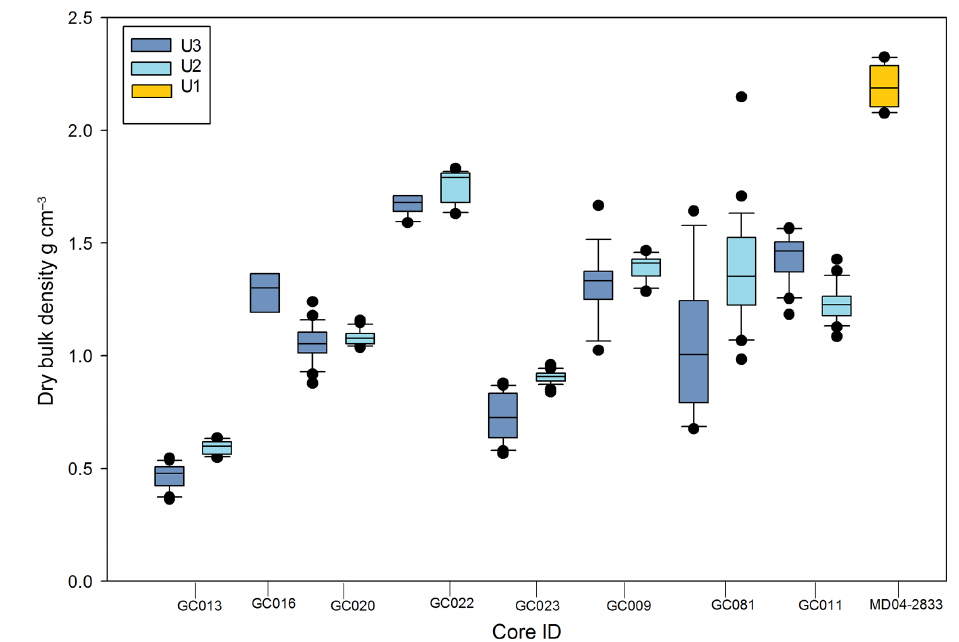
Figure 4. Dry bulk density values from each sediment cores corresponding to seismic units 1, 2 and 3.